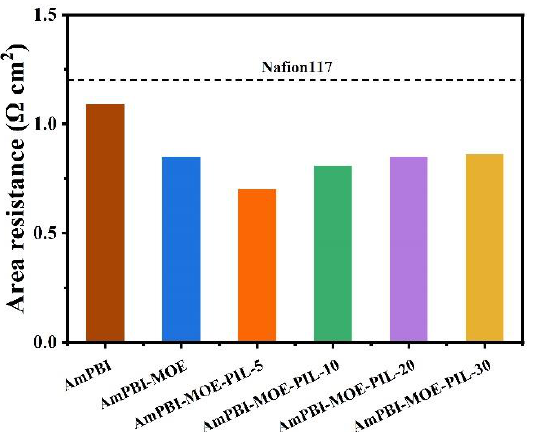
Figure 3. Vanadium concentration curve ( a ) and ion selectivity ( b ) of AmPBI, AmPBI-MOE-PIL-X membranes, and Nafion117.